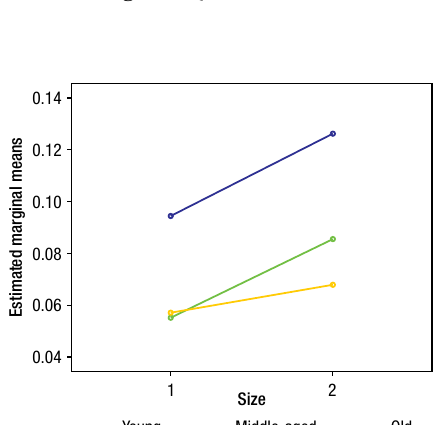
Fig. 1. EQUITY Variable